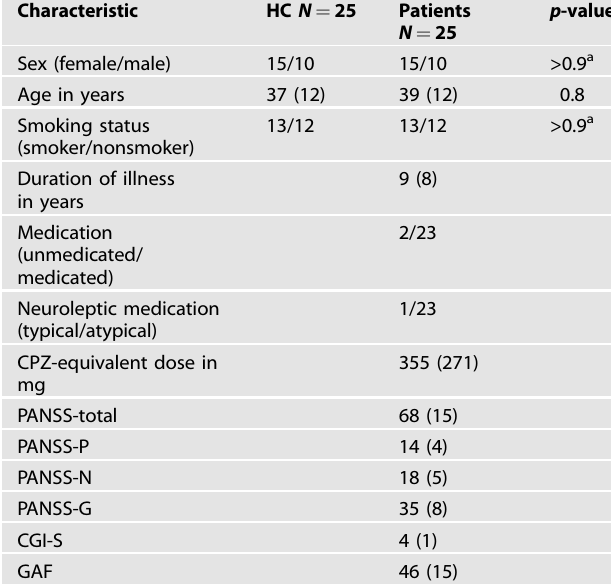
Table 1. Demographic and psychometric